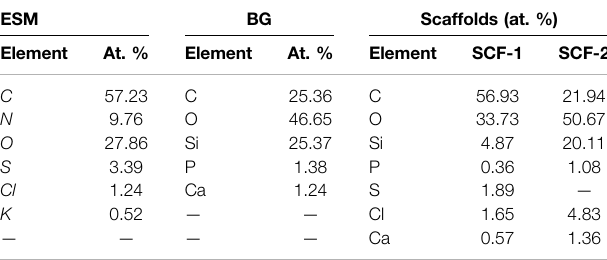
TABLE 1 | Chemical analysis by EDS of ESM, BG, and scaffolds